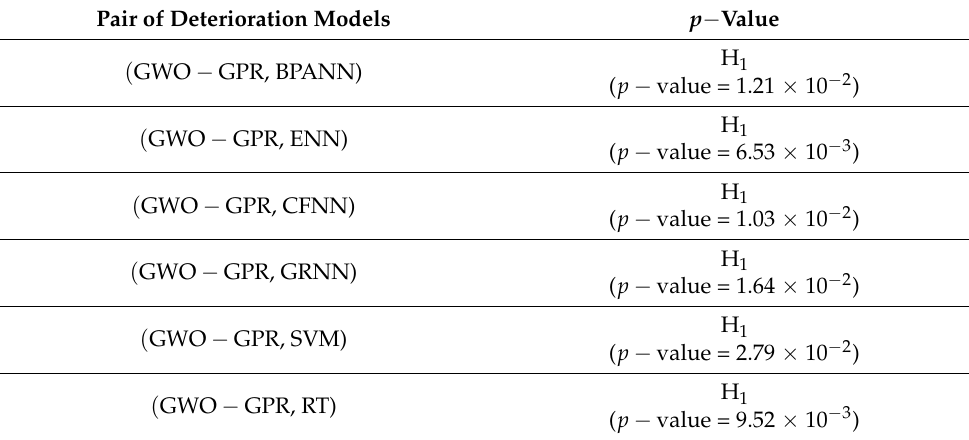
Table 10. Statistical comparison of the developed deterioration model against other models using RRSE based on Student’s t -test.